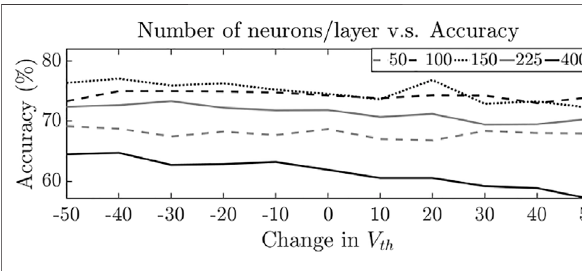
FIGURE 15 | Impact on number of neurons per SNN layer on classi fi cation accuracy under adversarial Vth